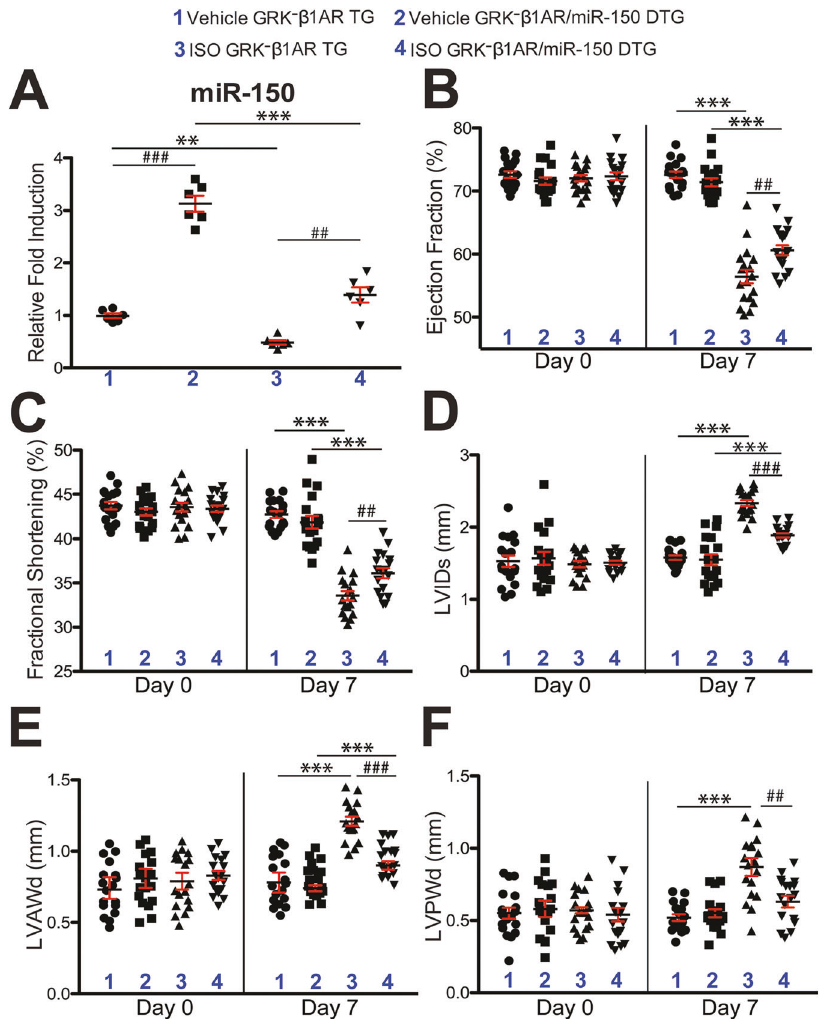
Fig. 1 Cardiomyocyte-speci fi c overexpression of GRK − β 1 AR exacerbates cardiac dysfunction following chronic isoproterenol treatment, which is in part rescued by miR-150. A MiR-150 expression in left ventricles (LVs) from cardiomyocyte (CM)-speci fi c GRK − β 1 AR transgenic